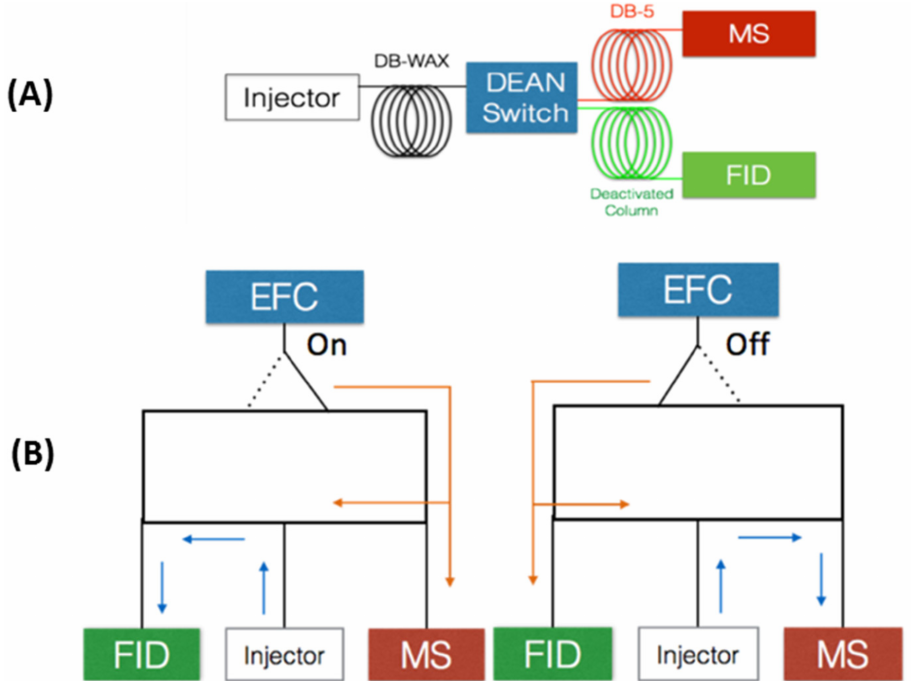
Figure 2. Column configuration for MD-GC system ( A ) and Dean switch schematics ( B ). Deans switch valve working diagram. EFC denotes for electronic flow control. Arrows denote the flow direction when EFC is switched “on”, flow directed to FID or “off”, flow directed to